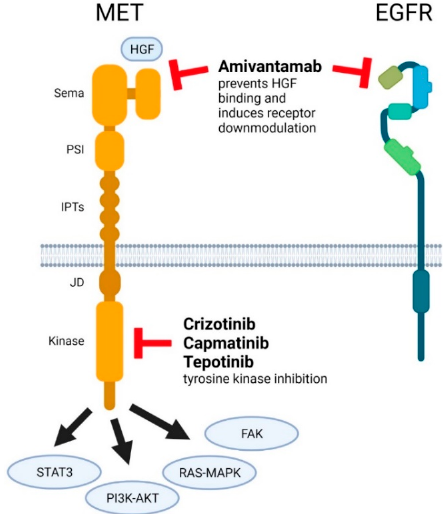
Figure 1. Target regions of MET inhibitors. Cartoon overview of the intra- and extracellular-domain structure of MET and the sites of inhibitor binding to MET and EGFR. Four major signaling pathways involved in MET signaling are indicated. Abbreviations: hepatocyte growth factor (HGF), Semaphorin (Sema), plexin-semaphorin-integrin (PSI), integrin-plexin-transcription factor (IPTs), juxtamembrane (JD), and epidermal growth factor receptor